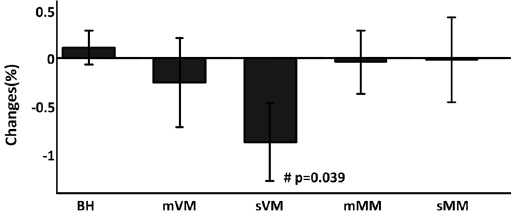
Figure 2. Relative changes of cerebral StO 2 in the last 5 s maneuvers compared to its baseline level. # Indicates significant differences. The error bars are standard error and n =